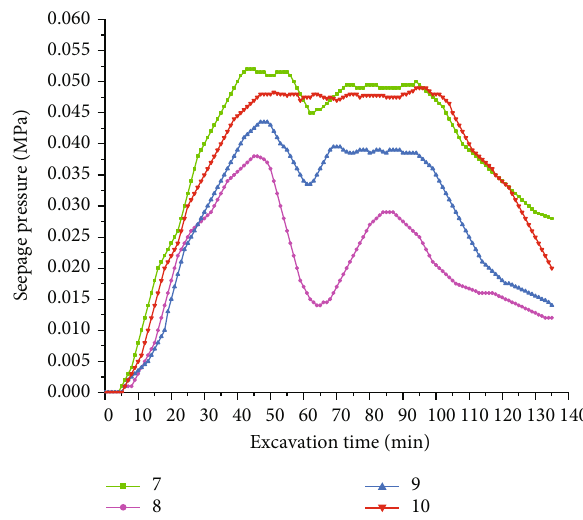
Figure 23: The changes of the seepage pressure on the tunnel vault with rainfall time.